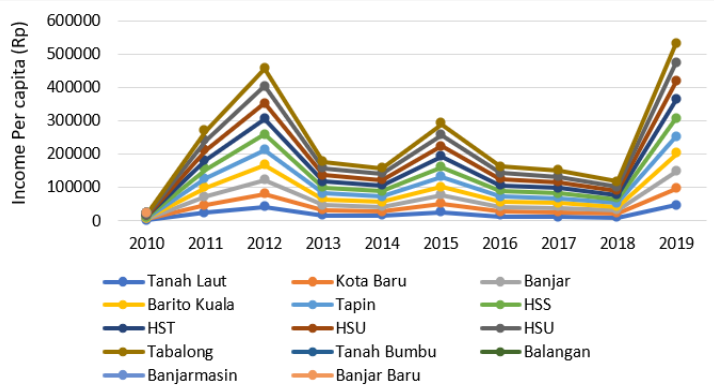
Figure 1: The Trend of Regional Income per Capita in South Kalimantan in